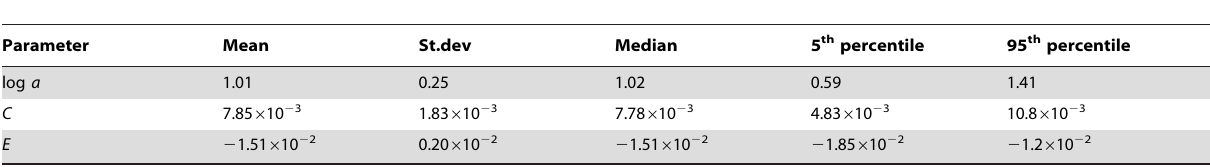
Table 2. Basic statistics of models parameters (see equations 3 and 4), as obtained by bootstrapping the 2005 and 2006.